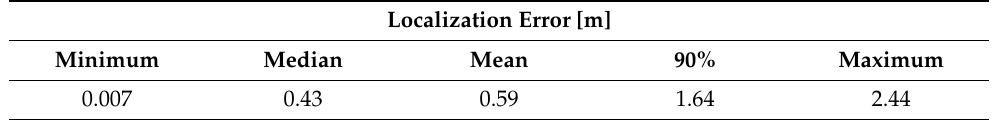
Table 1. Localization error of the dead reckoning algorithm.